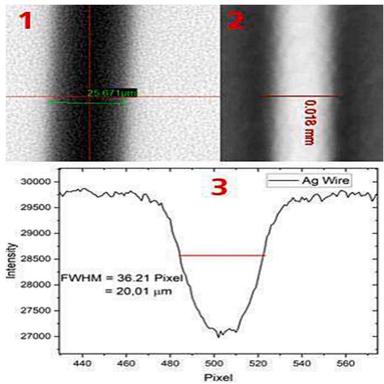
Non-destructive methods for measuring bond wire thickness using a 20.23 μm thick Silver bond wire as an example. Results of measurements from 2D imaging (d ≈ 26 μm) (1), CT/laminography (d ≈ 18 μm) (2), and FWHM from absorption profile (d ≈ 20 μm) (3).